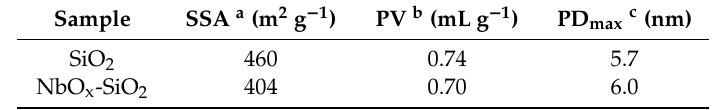
Table 2. Textural features of the original SiO 2 support and NbO x -SiO 2 catalyst.